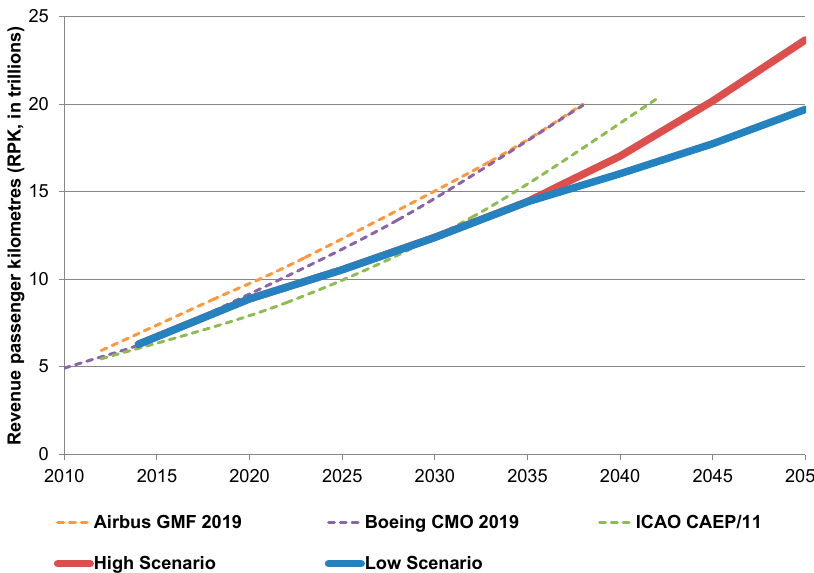
Figure 13. Comparison with the Airbus, Boeing and ICAO forecasts.